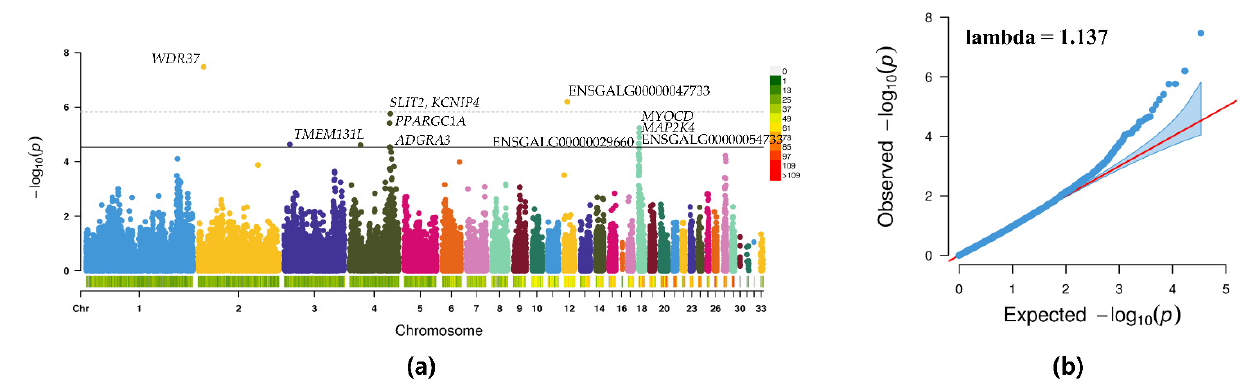
Figure 3. ( a ) Manhattan plots of mapped single nucleotide polymorphism (SNP) markers associated with body weight. Each dot corresponds to a SNP within the data set. The dot color represents the chromosome on which the SNP is located; the dot position represents the − log 10 -transformed p -value of the SNP. The horizontal dotted line denotes the genome-wide significance threshold level ( − log 10 ( p ) > 5.83); the solid line denotes the suggestive threshold level ( − log 10 ( p ) > 4.53). ( b ) Quantile–quantile plot of the genome-wide association study.